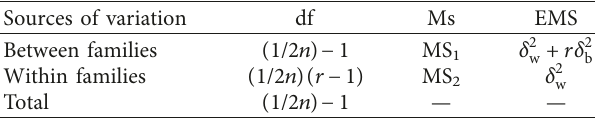
Table 2: Variance components for biparental mating design. Sources of variation df Ms EMS Between